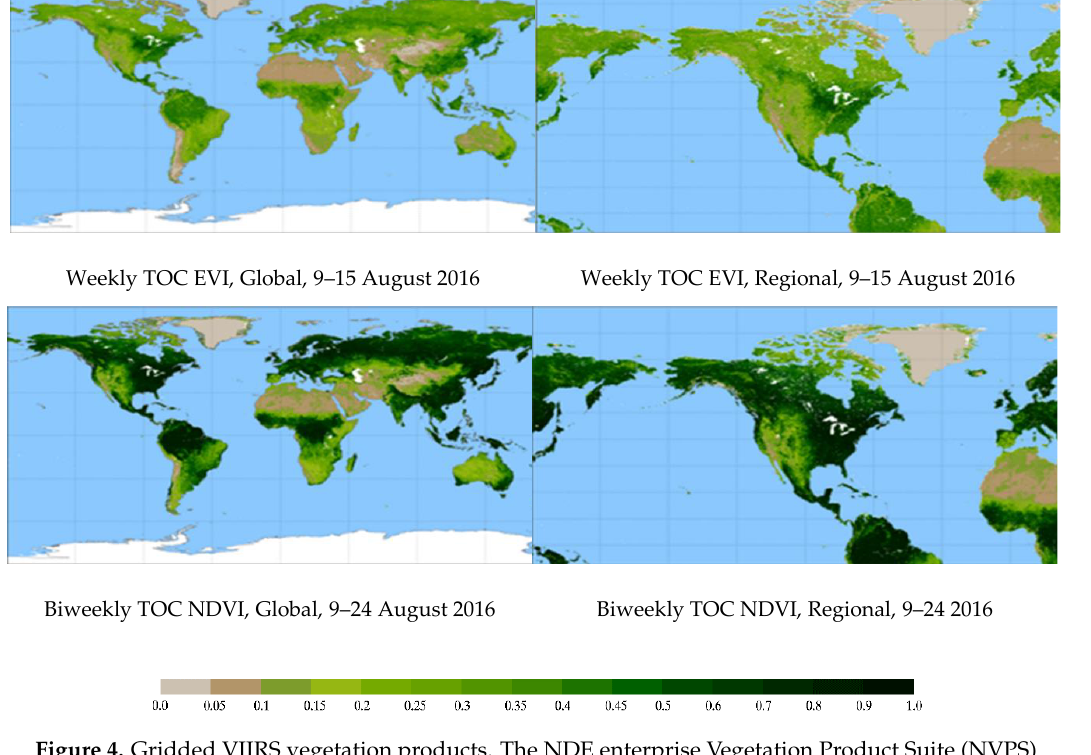
Figure 4. Gridded VIIRS vegetation products. The NDE enterprise Vegetation Product Suite (NVPS) includes a variety of Vegetation Index (VI) products and the GVF product. The product suite contains daily, weekly and biweekly global and regional (North America) products at 4 km and at 1 km spatial resolution, respectively (figure courtesy: Yunyue Yu, STAR VI/GVF